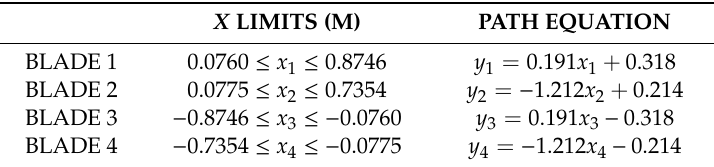
Table 1. Path equations of the blades’